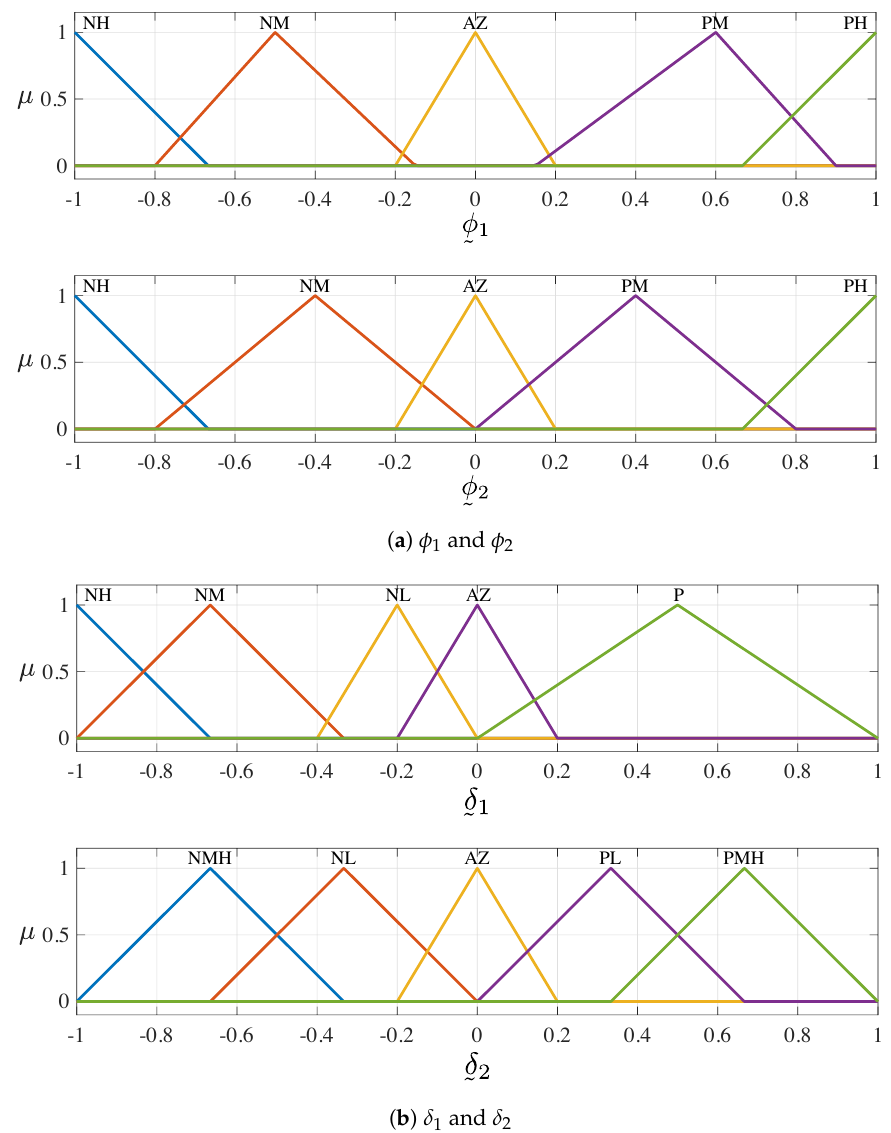
Figure 7. Membership functions of input